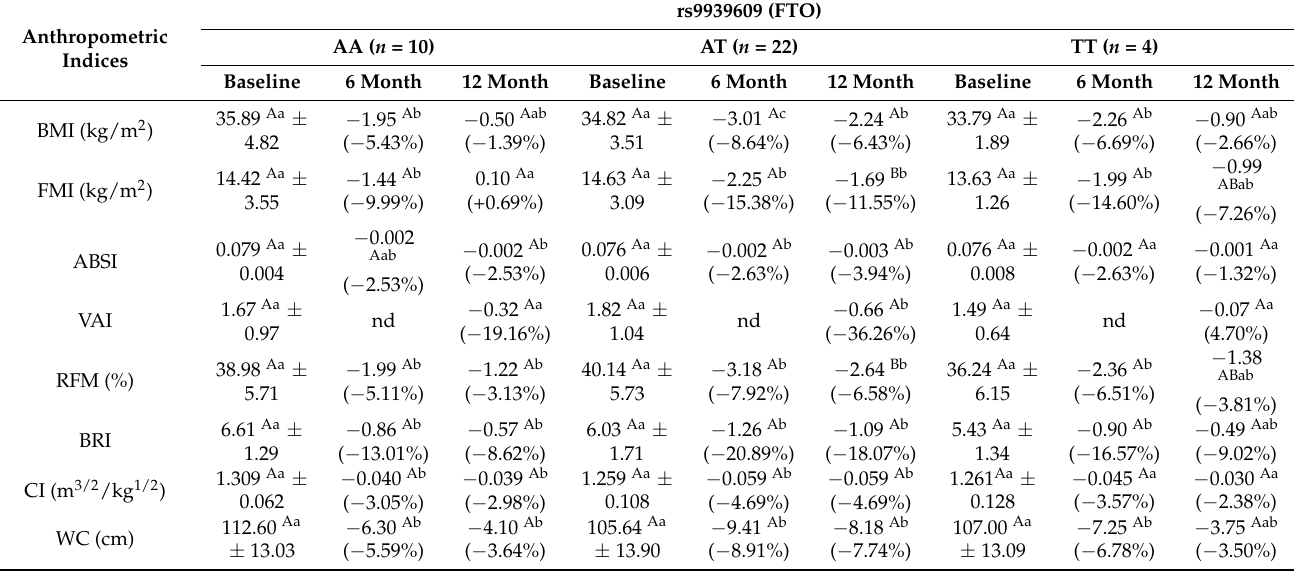
Table 5. Differences in changes in the anthropometric indices, depending on FTO rs9939609.